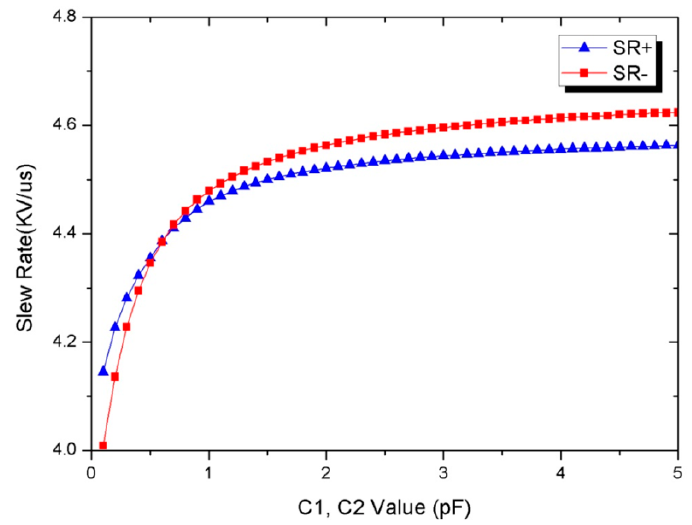
Figure 13. Simulated slew-rate of rising and falling edge of the level-shifter.